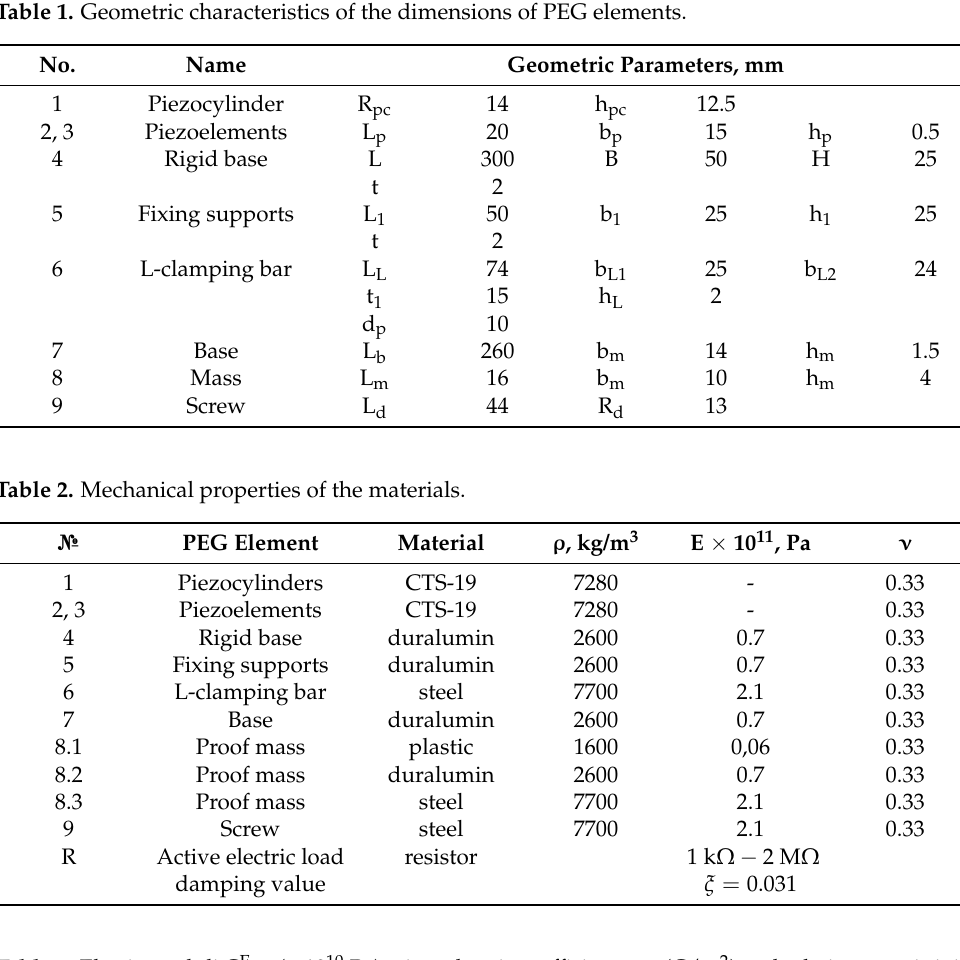
Table 3. Elastic moduli C E pq ( × 10 10 Pa), piezoelectric coefficients e kl (C/m 2 ) and relative permittivity ε ξ kk/ ε 0 of piezoceramics (based on measurements at room